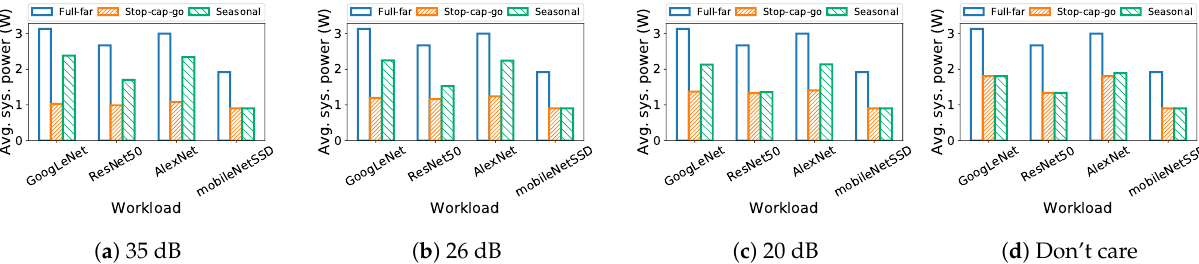
Figure 8. For seasonal migration, raised duty cycles decrease system power, while it increases the system power for